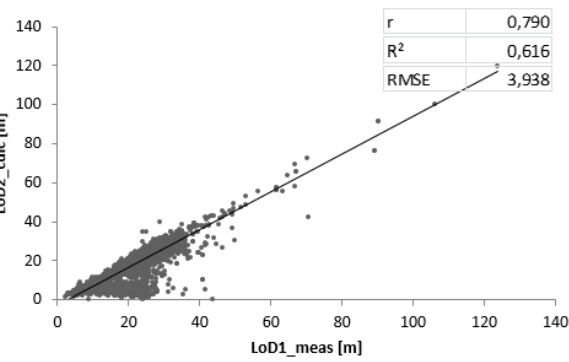
Figure 8. LoD1_meas height information plotted against LoD2_calc height